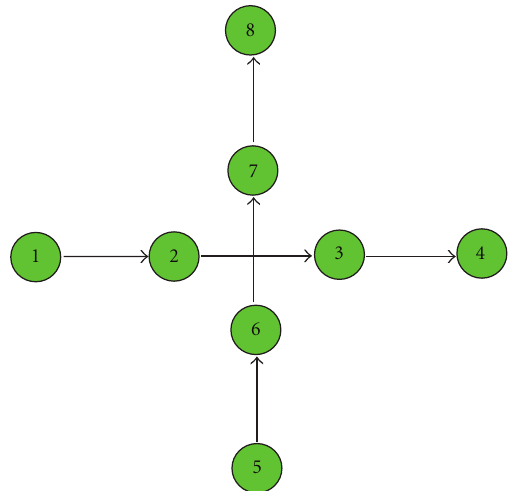
Figure 15: A multihop network consisting of total eight STAs. STA4 and STA8 are sink for source STA1 and STA5, respectively. Data flows are indicated by